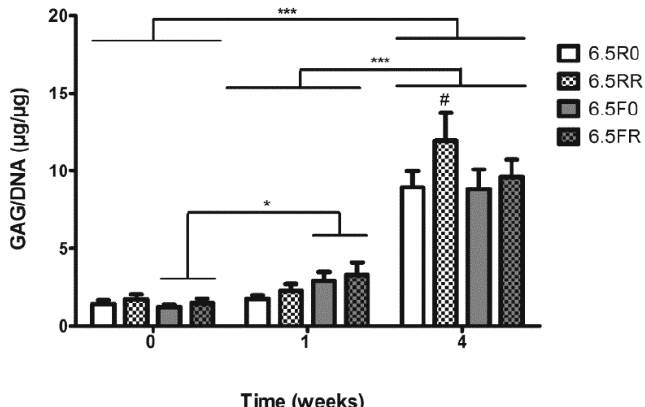
Figure 5. GAG/DNA content of encapsulated hPDCs within 6.5% ( w / v ) PEG hydrogels composed of two different types of cross-linkers (F or R) and functionalized with 150 or 0 µ M RGD, when cultured in 4C chondrogenic medium. 6.5R0 = R cross-linker + 0 µ M RGD; 6.5RR = R cross-linker + 150 µ M RGD; 6.5F0 = F cross-linker + 0 µ M RGD; 6.5FR = F cross-linker + 150 µ M RGD. Results are depicted as mean ± SD. (Two-way ANOVA, n = 3; *** p < 0.001; * p < 0.05; # p < 0.05 when comparing to other